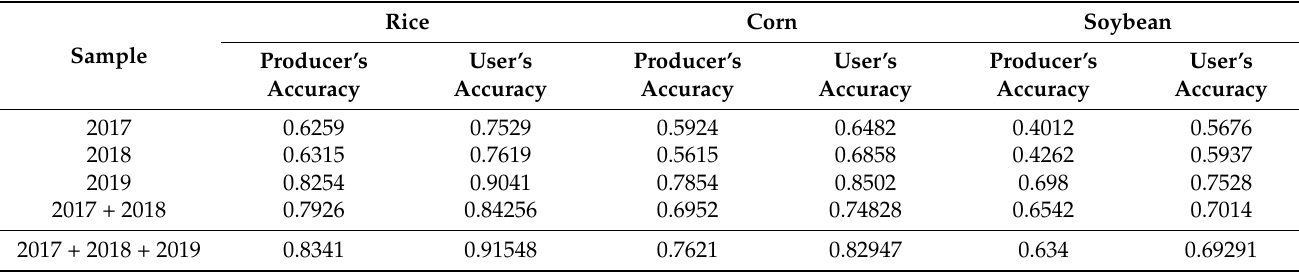
Figure 6. Classification performance changes with time; ( a ) 2017 data vs. 2019 classification results; ( b ) 2018 data on 2019 crop classification results; ( c ) 2019 data on 2019 crop classification results; ( d ) coupling 2017 and 2018 data to 2019 crop classification results; ( e ) classification results of 2017, 2018 and 2019 data for 2019. Table 2. Classification producer’s accuracy and user’s accuracy of samples from different